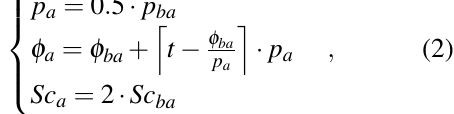
Figure 1: Robot dancing system